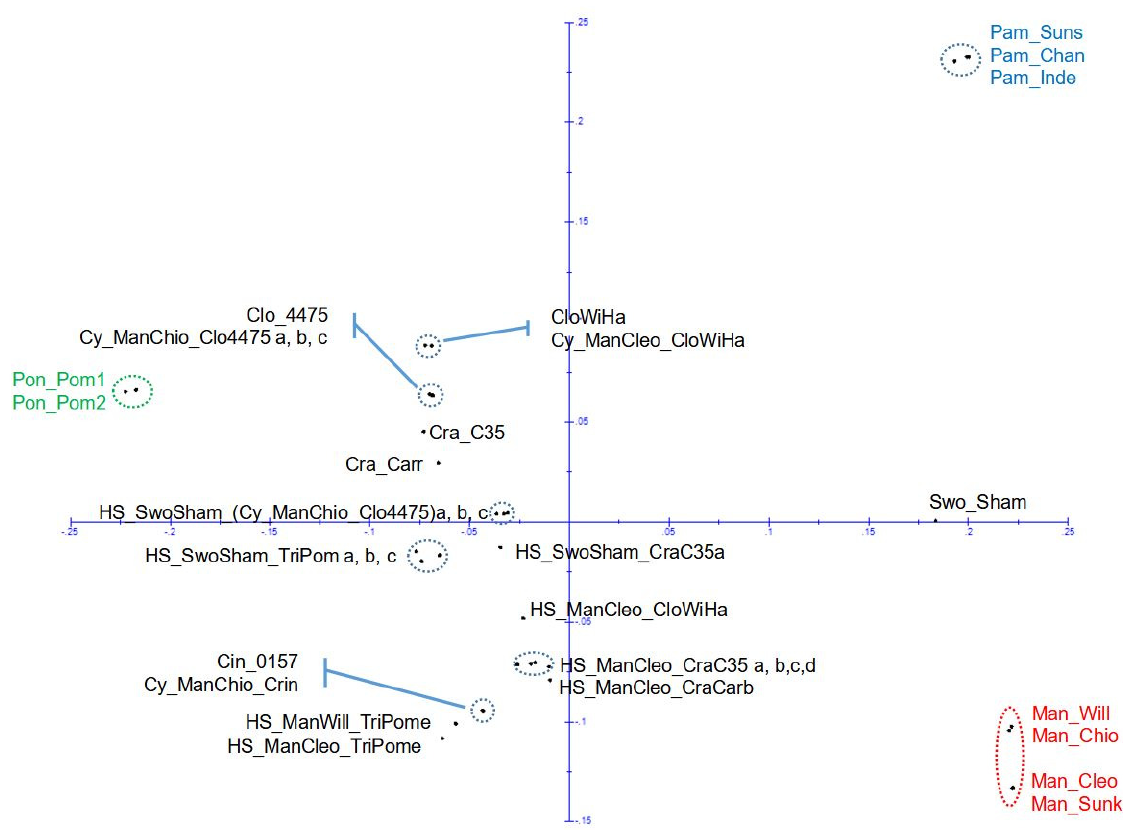
Figure 5. Factorial analysis on a dissimilarity matrix based on 46,826 nuclear SNPs.